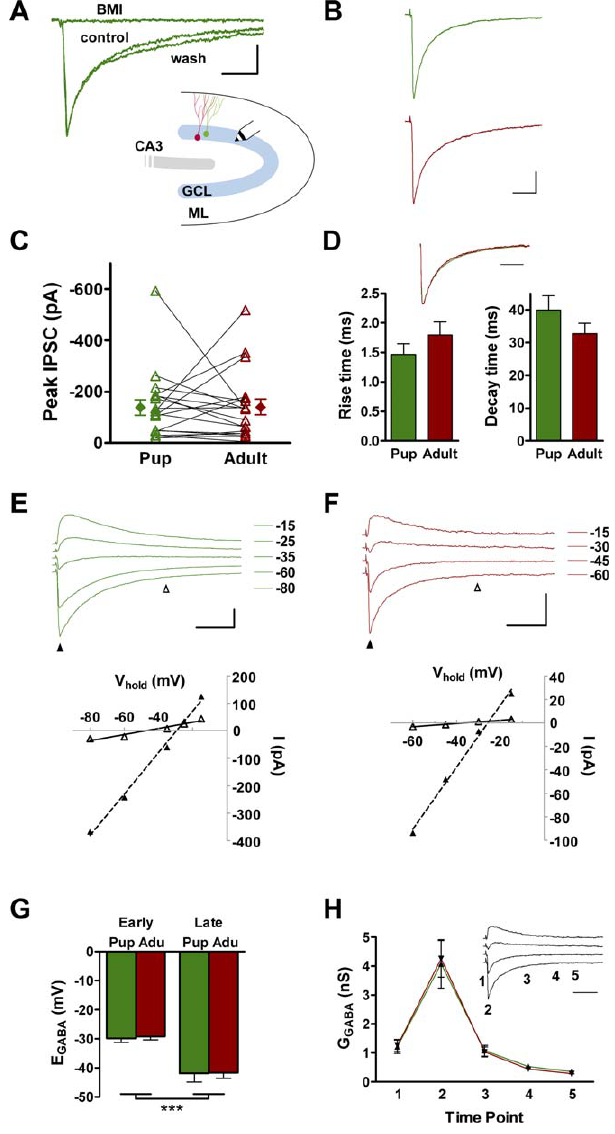
Figure 4. GABAergic Inputs Elicited by GCL Stimulation (A) Example of evoked IPSCs recorded from a pup-born DGC in response to extracellular stimulation of the GCL before (control), during (BMI), and after (wash) application of 20 l M BMI. Scale bars indicate 25 ms, 20 pA. Inset: schematic diagram of the DG showing the position of the